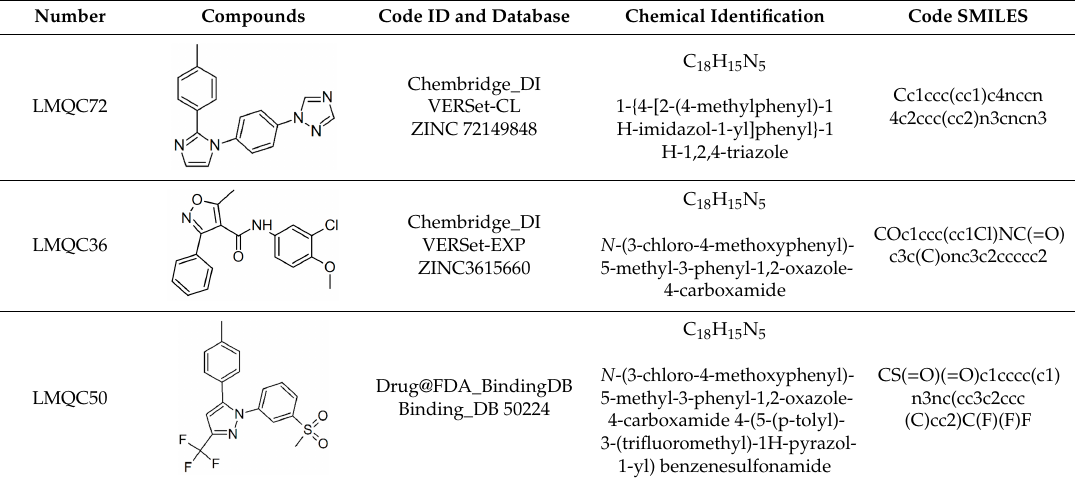
Table 5. Selected structures resulting from the molecular docking.